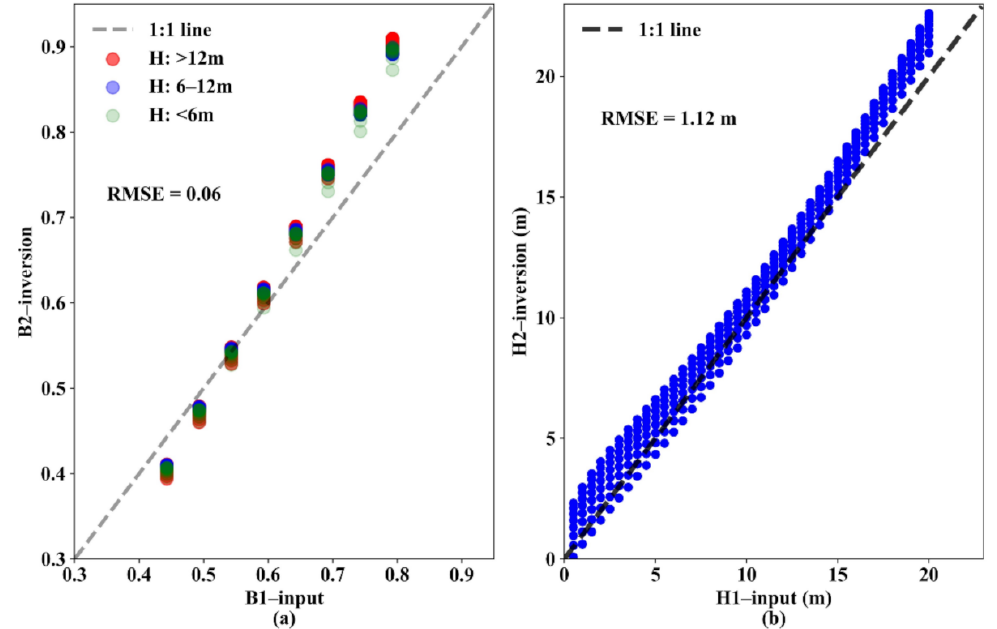
Figure 3. Fitting curve of the inversion result B2 , H2 , and Hydrolight input value B1 , H1 : ( a ) B2–B1 ( b ) H2–H1